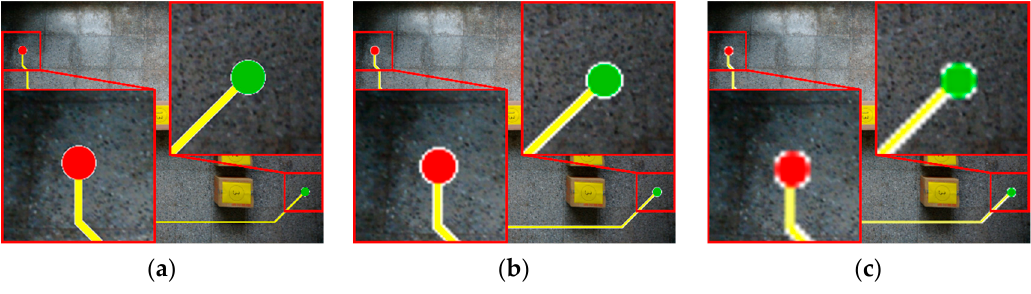
Figure 17. Final output: ( a ) mode6; ( b ) mode7; ( c ) mode8.